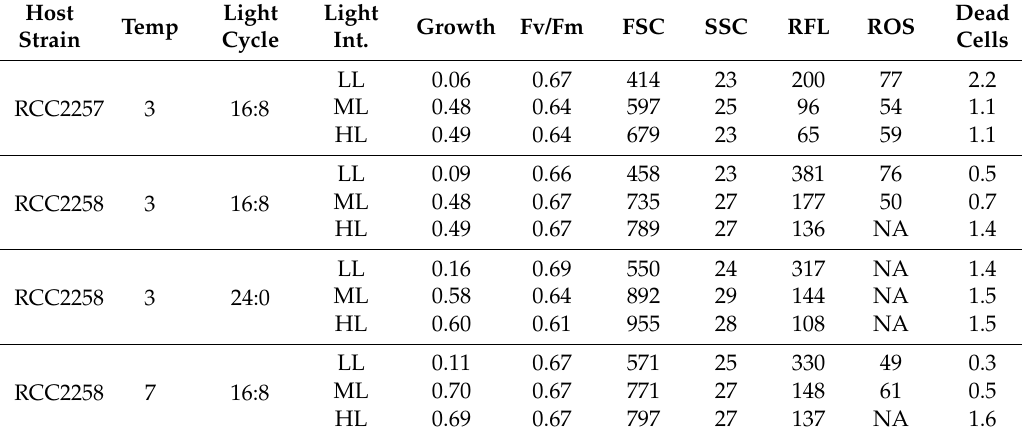
Table 1. Exponential growth rates (Growth, d − 1 ), photosynthetic efficiency (Fv/Fm, r.u.), mean cellular forward and side scatter (FSC and SSC, r.u.), red Chlorophyll autofluorescence (RFL, r.u.), cellular reactive oxygen species Content (ROS, r.u.) and dead cells (%) of Micromonas polaris RCC2258 and RCC2257 adapted to an incubation temperature (Temp) of 3 or 7 ◦ C, a 16:8 h or 24:0 h light:dark cycle and at a light intensity (Light Int.) of 5 (LL), 60 (ML) or 160 (HL) µ mol quanta m − 2 s − 1 . Cultures under 16:8 h light condition displayed synchronized cell division and therefore cellular characteristics were averages over a 24 h diel cycle. R.u. stands for relative units, NA stands for not